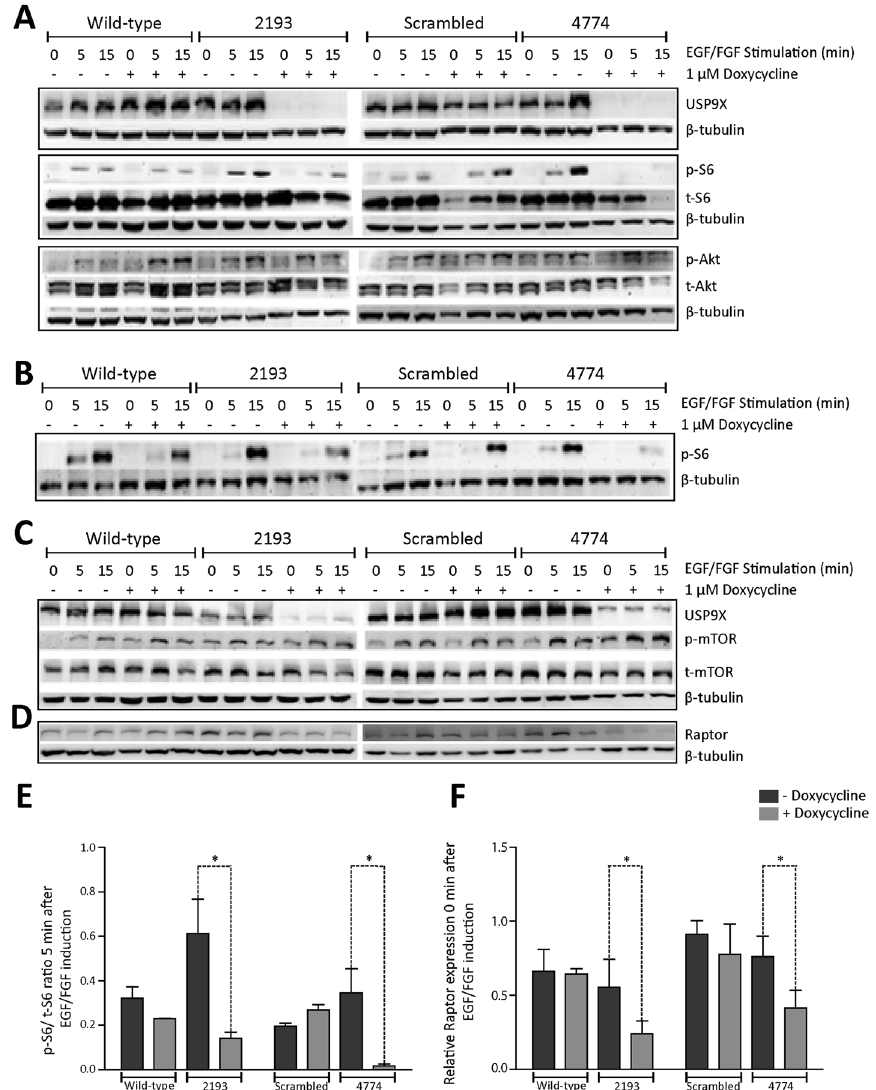
Figure 3. mTORC1 activity and RAPTOR levels in ReNcell VM cells are dependent on USP9X. ( A ) Immunoblot analysis of growth factor induction of mTORC1 and mTORC2 pathways in absence of USP9X. USP9X was depleted from 2193 and 4774 cells by 72 hours exposure to doxycycline before growth factors (EGF/ FGF) were removed from ReNcell VM medium 24 hours prior to protein collection (0 minutes) and then 5 and 15 minutes after re-addition of EGF/FGF. Both pS6 and pAkt levels increased upon exposure to EGF/FGF (compare 0 to 5 and 15 min) indicating both mTORC1 and mTORC2 pathway activation, respectively. However, the extent of induction for pS6 was markedly reduced in the absence of USP9X (compare plus and minus Dox at 5 and 15 mins in 2193 and 4774). Total S6 and Total AKT were not affected by USP9X depletion. Representative of three biological repeats. ( B ) Diminished mTORC1 activation in ReNcell VM cells, as determined by pS6 levels, was evident after only 24 hours doxycycline treatment, consistent with the xCELLigence data. ( C ) Phospho and Total mTOR levels were unaffected by the absence of USP9X. Representative of two biological replicates. Full length blots presented in Supplementary Fig. S8. ( D ) RAPTOR protein levels were decreased in ReNcell VM cells with depleted USP9X (2193 and 4774 plus doxycycline) Representative of three biological replicates. ( E ) Densitometric quantitation, of immunoblots from two biological replicates, of initial pS6 induction compared to total S6 levels 5 mins after addition of EGF/FGF in the absence or presence of doxycycline. The treatment of cells with doxycycline significantly attenuated the level of pS6 in 2193 and 4774 cells only. ( F ) Densitometric quantitation of immunoblots, from three biological replicates, of RAPTOR protein, relative to β -tubulin control, at time 0 hour in the absence or presence of doxycycline. The treatment of cells with doxycycline significantly attenuated the level of RAPTOR in 2193 and 4774 cells only. All data are shown as the means ± SEM. Statistical significance was assessed by the unpaired Student’s t test. * p <